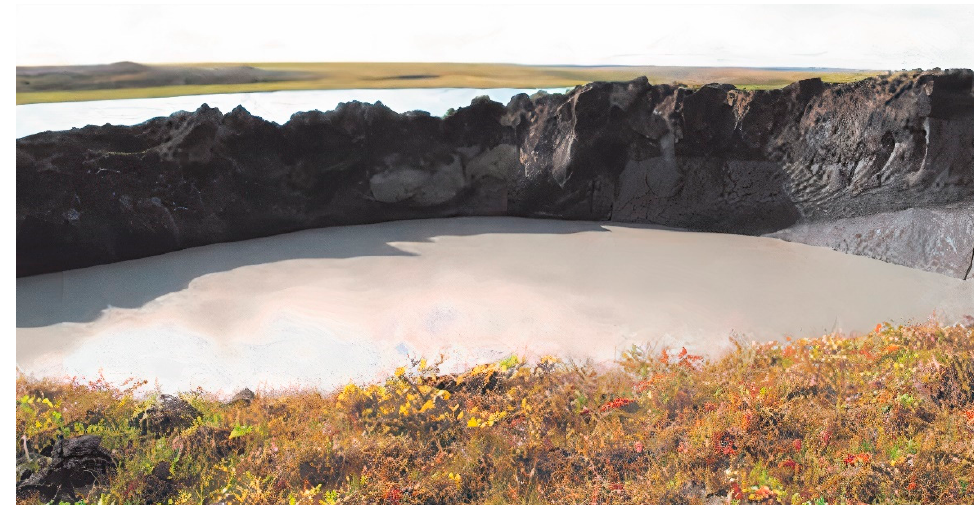
Figure 6. A crater on the left bank of the Mongoche River (Gydan Peninsula), summer 2014. Photograph by Epifanov [9] (number on the map: 10).